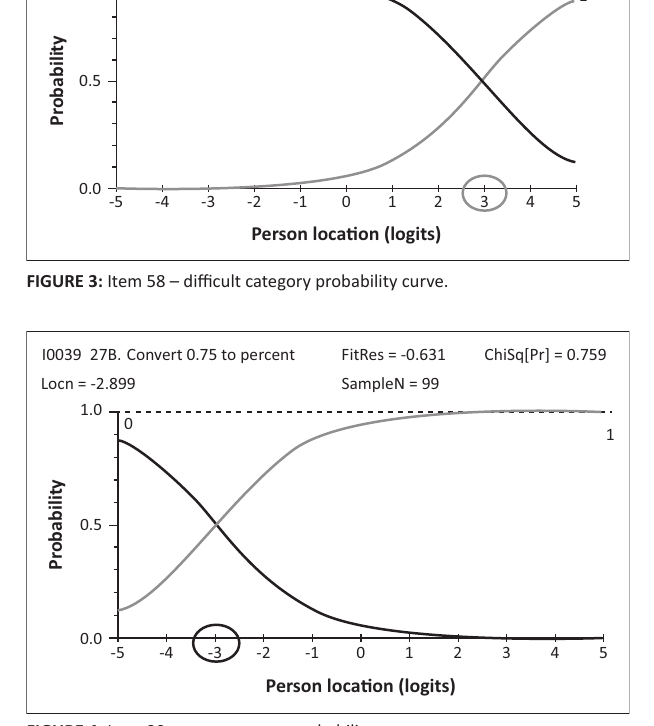
FIGURE 4: Item 39 – easy category probability curve.